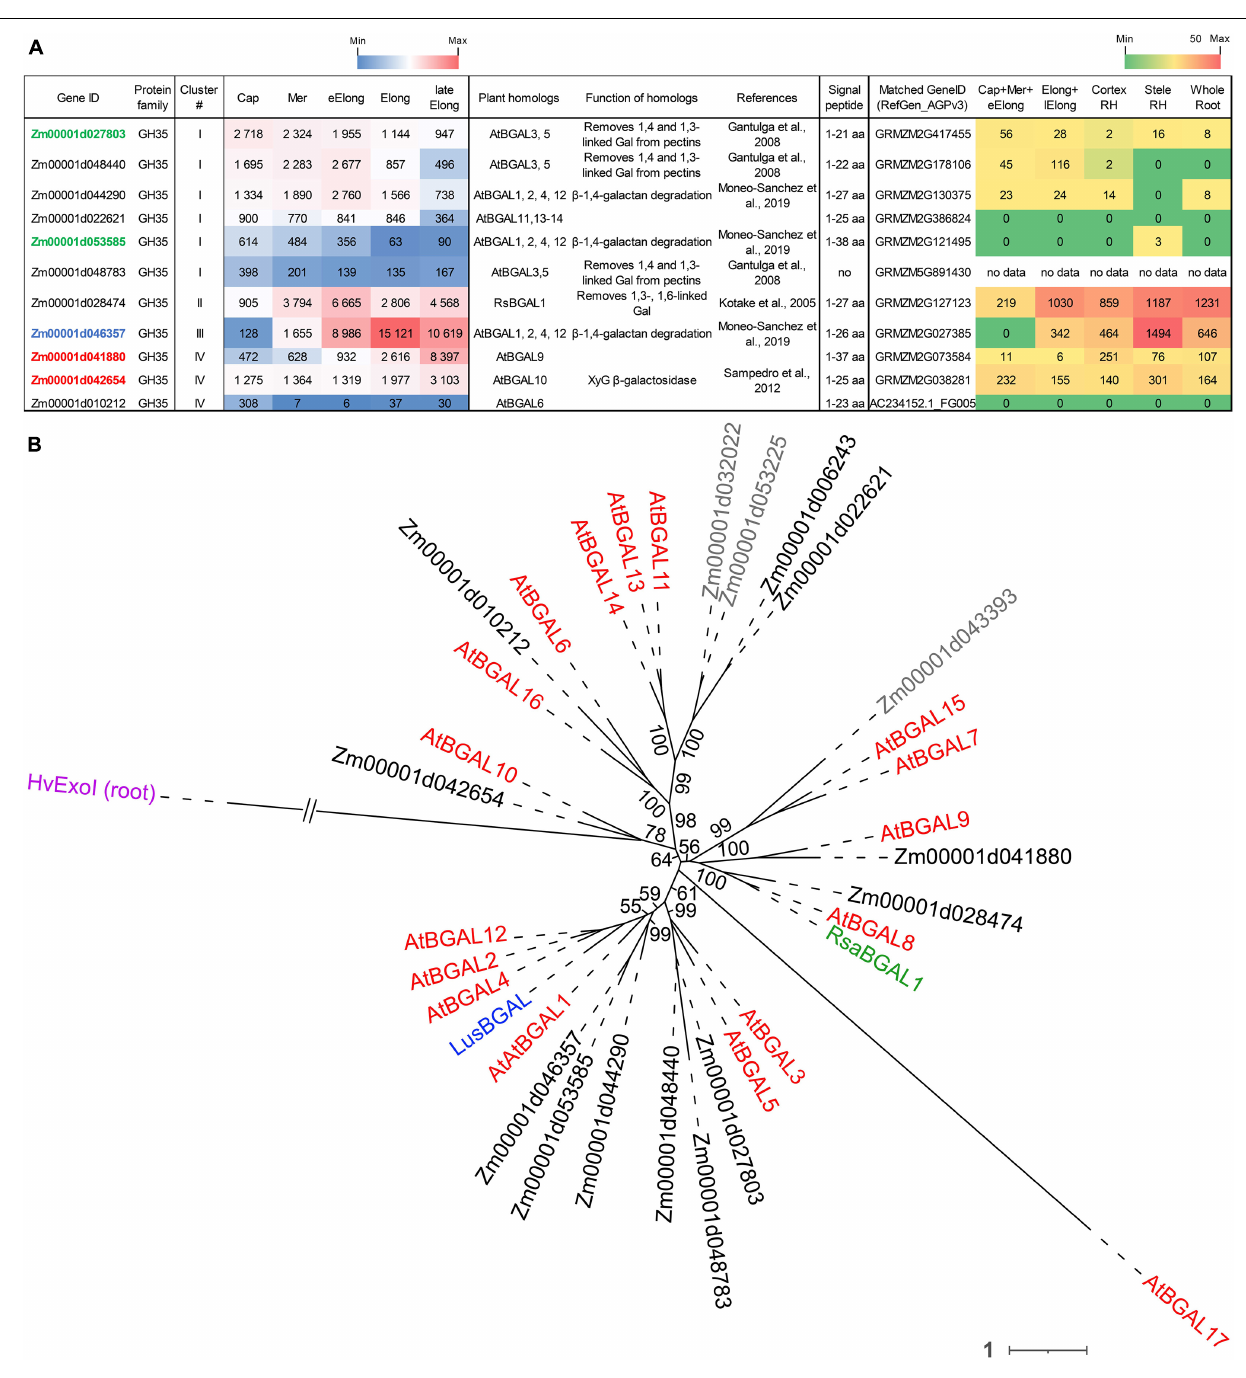
FIGURE 4 | Expression of maize genes encoding putative GH35 β - D -galactosidases in maize roots and phylogenetic analysis of plant GH35 family. (A) The level of transcripts (TGR, red-blue heat map) and abundance of corresponding proteins (averaged and normalized total spectral counts (Marcon et al., 2015), red-green heat map) of genes encoding putative β - D -galactosidases of the GH35 protein family in various zones of maize roots. Genes with expression values below 100 in all the studied samples are not shown. TGR values are sorted from maximum to minimum within each cluster. Maize genes co-expressed with primary and secondary cell wall cellulose-synthases, and with the XyG backbone synthase are given in blue, red, and green, respectively. XyG, xyloglucan; Gal, galactose; aa, amino acids; Cap, root cap; Mer, meristem; eElong, early elongation zone; Elong, zone of active elongation; lateElong, zone of late elongation before root hair initiation; RH, root hair zone; no data, no corresponding peptides were found by Marcon et al. (2015) proteomic analysis. (B) Unrooted maximum likelihood phylogenetic tree of GH35 protein family members. Maize expressed genes are given in black, and unexpressed (TGR values lower than 16 in all the analyzed root samples) in gray, Arabidopsis thaliana genes in red, flax LusBGAL (Roach et al., 2011) in blue, and radish RsBGAL1 (Kotake et al., 2005) in green. Arabidopsis gene names follow Chandrasekar and van der Hoorn (2016). HvExoI was used as outgroup, and branch length was shortened. Numbers indicate ultrafast bootstrap support values for some branches.